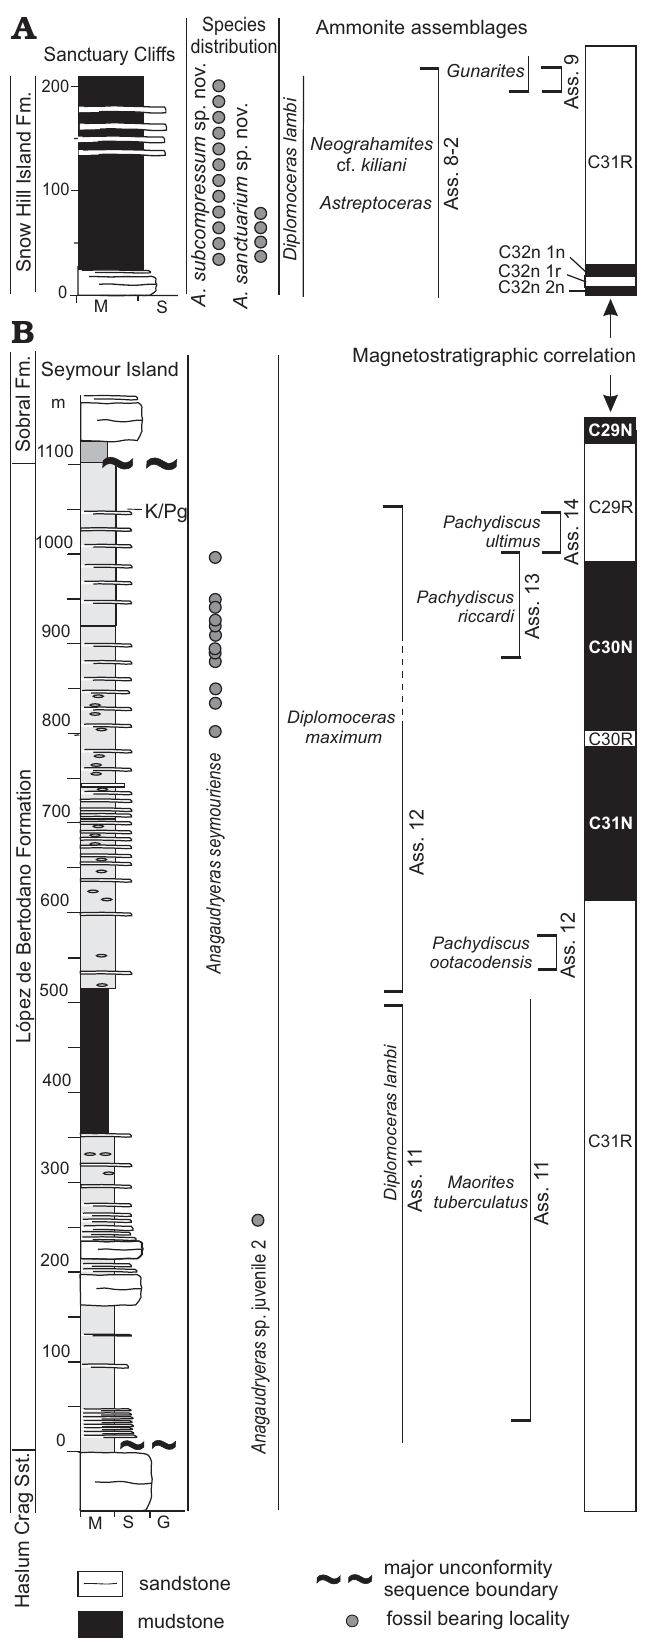
Fig. 3. Biostratigraphy of Anagaudryceras in the Sanctuary Cliffs Member, Snow Hill Island Formation, Antarctica, early Maastrichtian ( A ) and the López de Bertodano Formation, Seymour Island, late Maastrichtian ( B ). Ammonite assemblages by Olivero (2012b), magnetostratigraphic cor- relation for the Snow Hill Island Formation by Milanese et al. (2017a, b) and for the López de Bertodano Formation by Tobin et al. (2012). Abbreviations: A. , Anagaudryceras ; Ass., ammonite assemblage; Fm., Formation; G, gravel; M, mud; S, sand; Sst.,